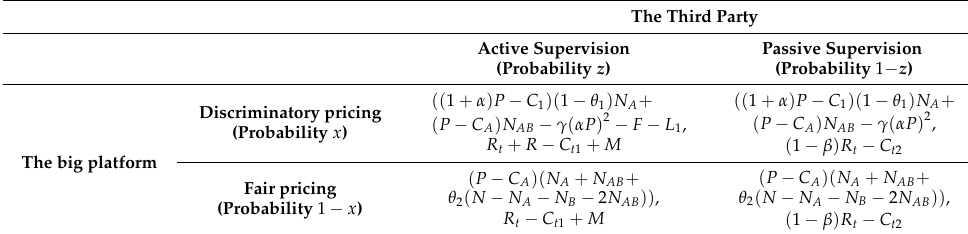
Table 4. Payment matrix of the big platform and the third